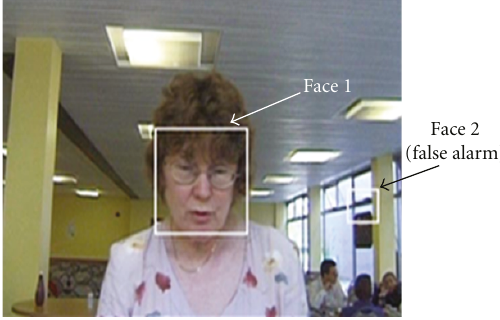
Figure 2: Face detection and